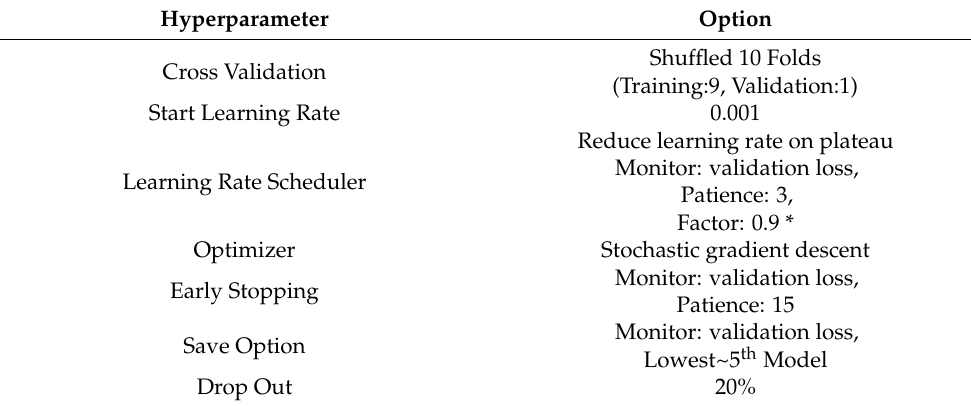
Table 7. Hyperparameter settings for model